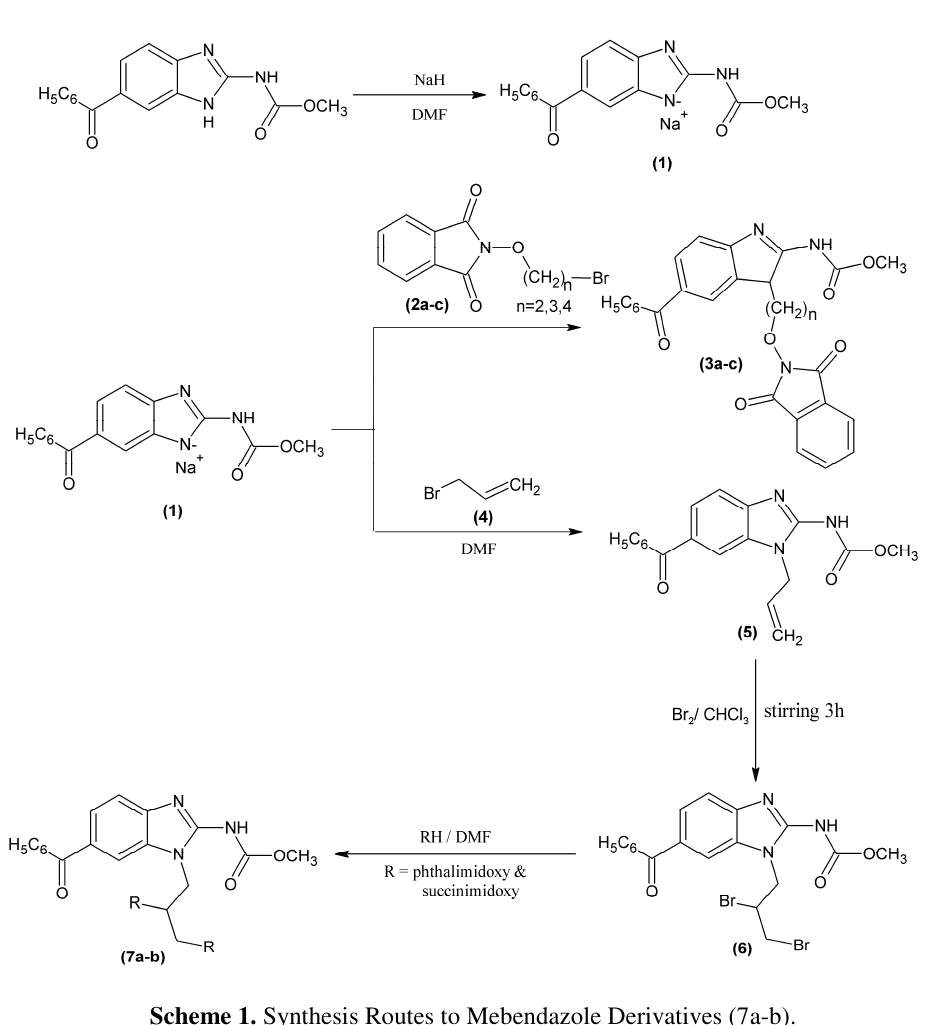
Table 1. Physical Data of Synthesized Compounds